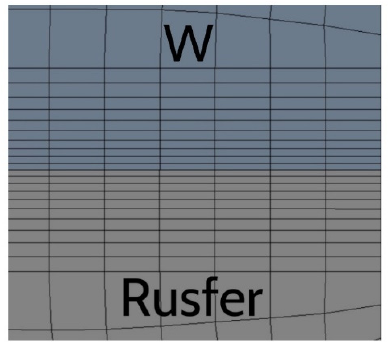
Figure 1. Test component ( a ) and boundary conditions for FEM model ( b ). The mesh near the contact region for FEM calculations is shown in Figure 2. There growth rate in the vertical direction is 1.1.